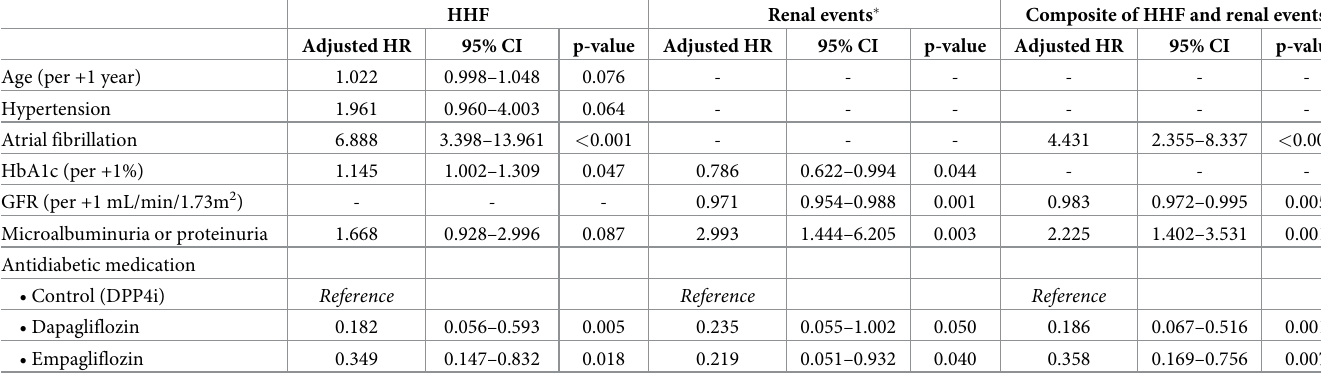
Table 4. Multivariable predictors of HF and renal